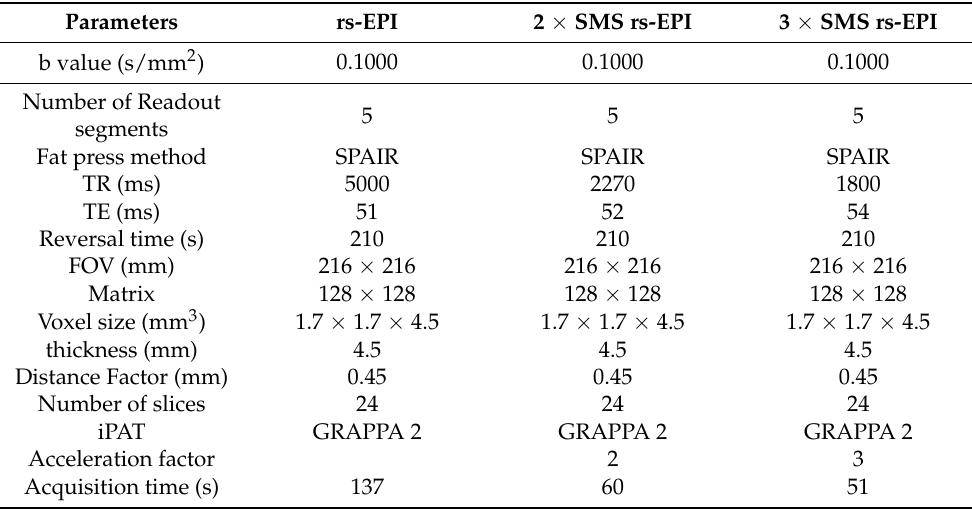
Table 1. The parameters of three DWI